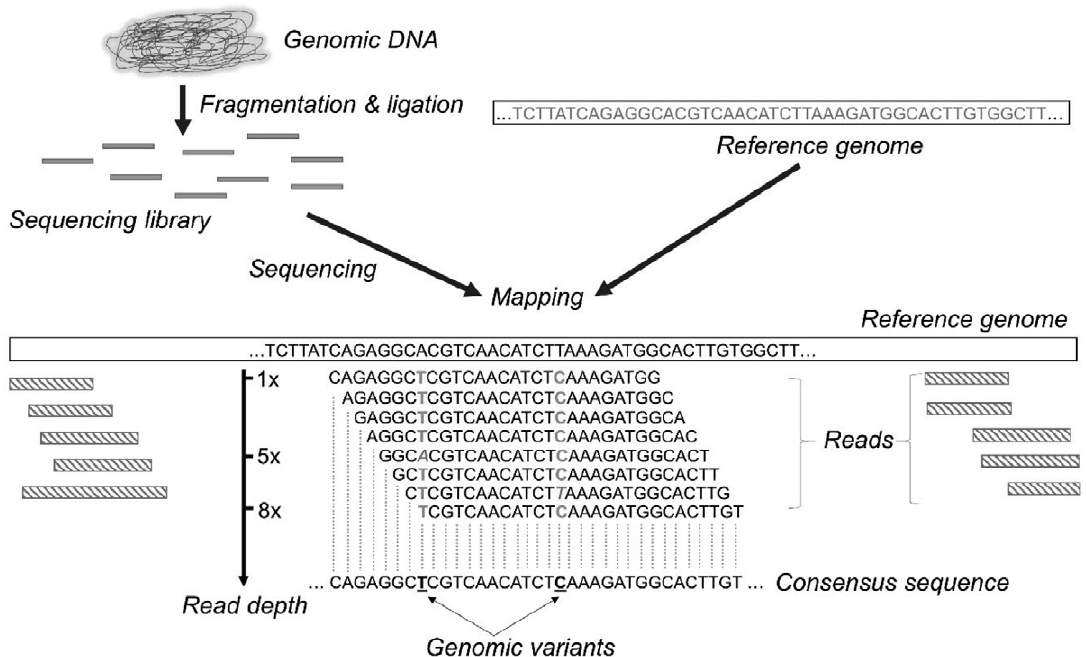
Figure 2: Schematic representation of NGS workflow. Steps common to different NGS platforms are DNA fragmentation (that is required or not depending on the library type), library preparation, massive parallel sequencing, bioinformatics analysis, and variant annotation and interpreta- tion. 27 Sequencing generates billions of “reads” that are computationally aligned to the reference genome to assemble linear consensus sequence. The number of reads in which a particular base/variant appears is known as a read depth and determines the confidence with which a particular base/ variant is called. 12 A particular single nucleotide variant should appear in more than 10 reads (meaning read depth to be at least 10 x) to be regarded as a genuine genomic variant.